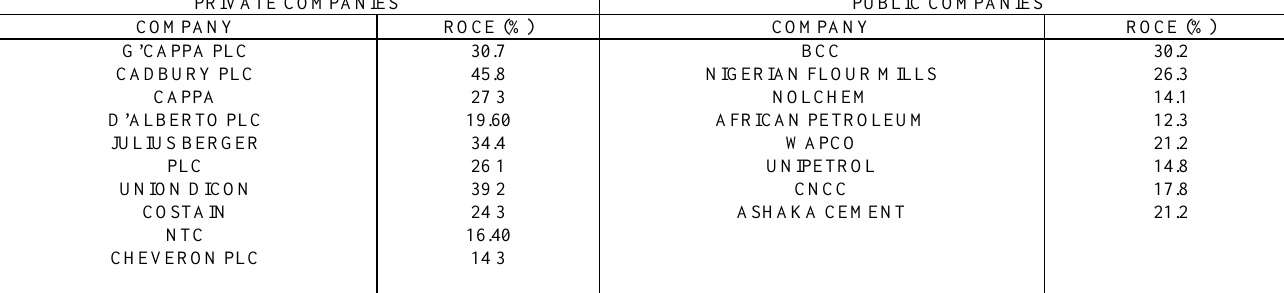
TABLE 9: RETURN OF CAPITAL EMPLOYED (ROCE) RATIO OF SELECTED COMPANIES (1990) PRIVATE